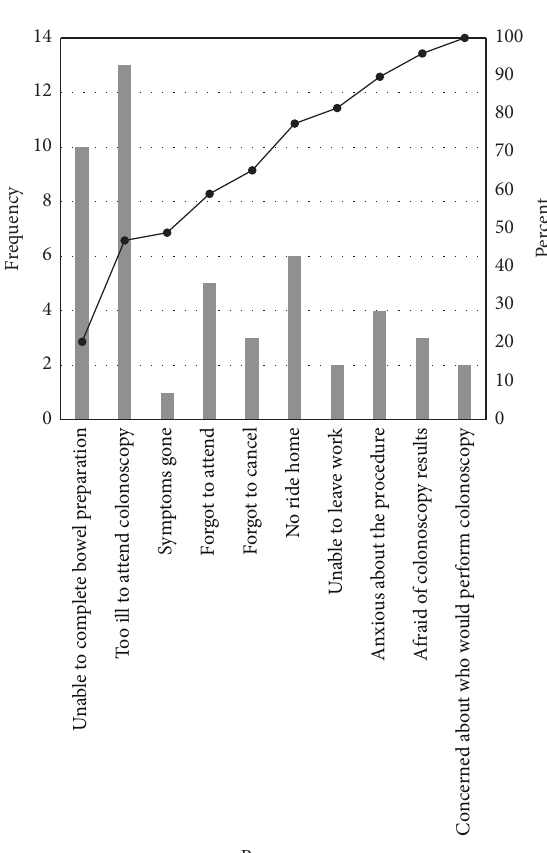
Figure 1: Distance of patients from Hotel Dieu Hospital.